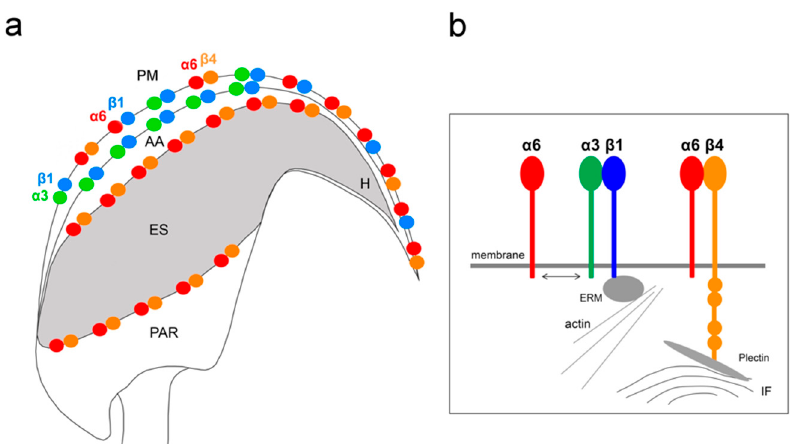
Figure 7. Graphical summary of integrin heterodimers and their localization in intact sperm head. ( a ) Localization of integrin heterodimers as follows: α 3 β 1, α 6 β 1, α 6 β 4–plasma membrane (PM) overlaying the apical acrosome (AA), α 6 β 1, α 6 β 4–sperm hook (H); α 3 β –outer acrosomal membrane of apical acrosome (AA); α 6 β 4–inner acrosomal membrane and equatorial segment (ES) up to posterior post-acrosomal region (PAR). ( b ) Schematic depiction of integrin subunits anchored in the membrane, dynamics between α 3 and α 6 with β 1 and β subunits interaction with cytoskeleton.